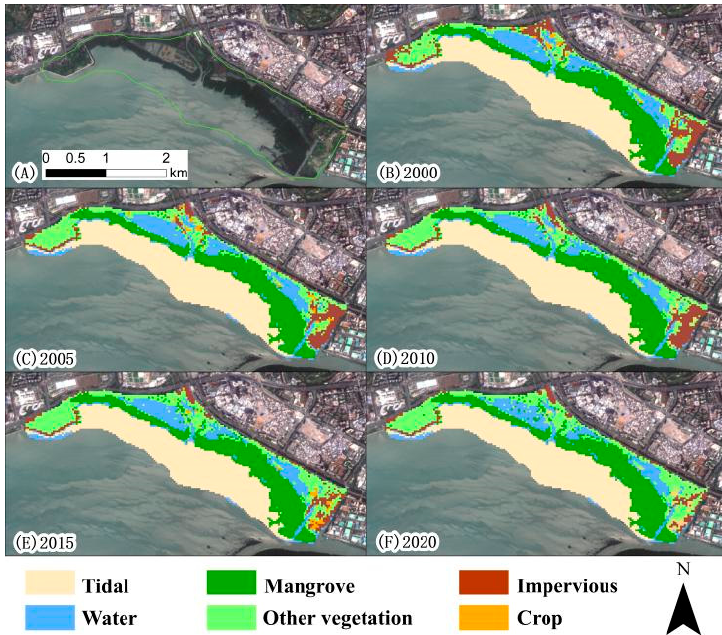
Figure A2. The spatiotemporal changes of mangrove forests in GZCNWP from 2000 to 2020. ( A ): the image of GZCNWP, ( B ): 2000, ( C ): 2005, ( D ): 2010, ( E ): 2015, ( F ): 2020.